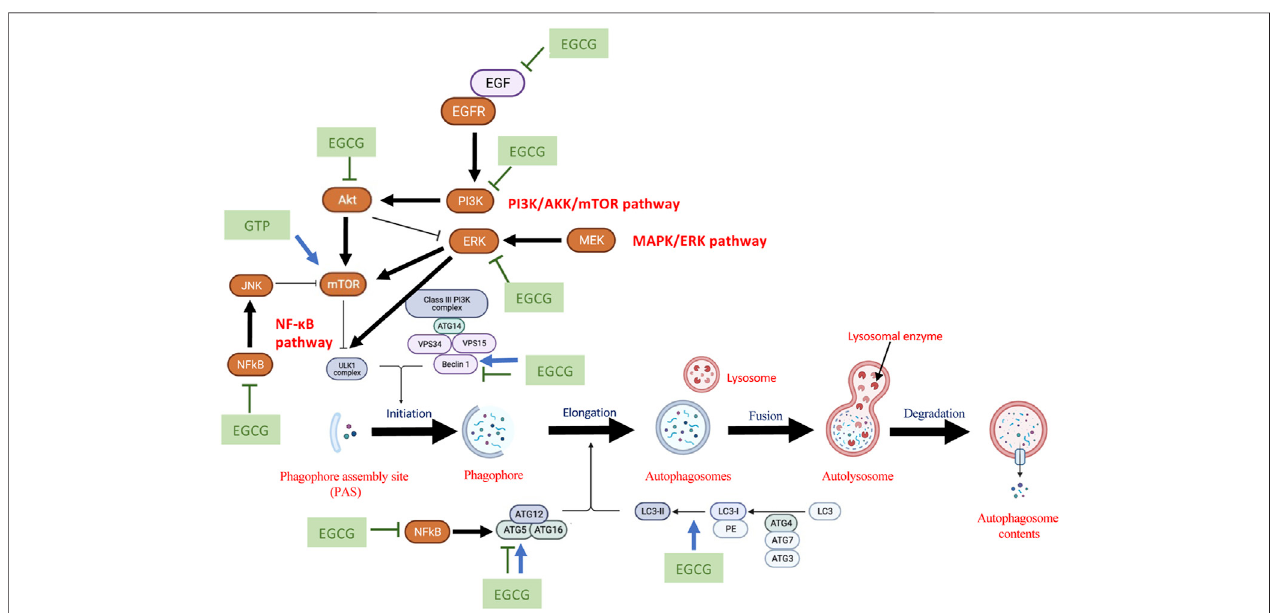
FIGURE 2 | The schematic diagram of potential chemopreventive mechanisms of EGCG and green tea catechins to regulate autophagy. The schematic diagram was created using BioRender.com.